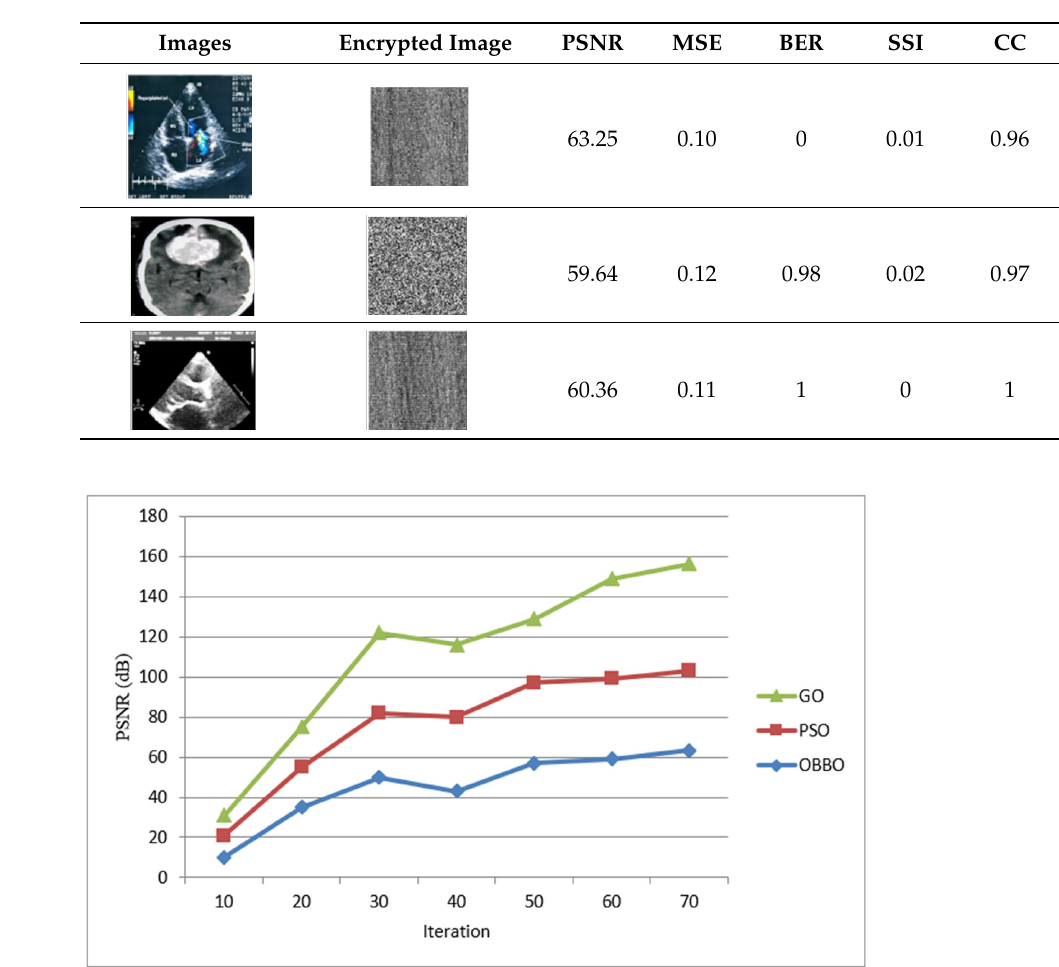
Figure 4. Fitness evaluation.